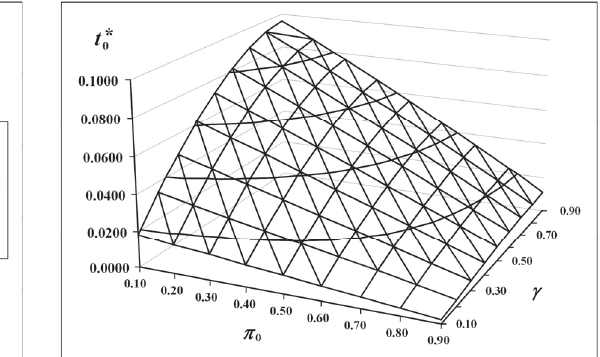
Fig. 10. The collective impact of π 0 and γ on the sum of optimal uptime and rework time t 0 *